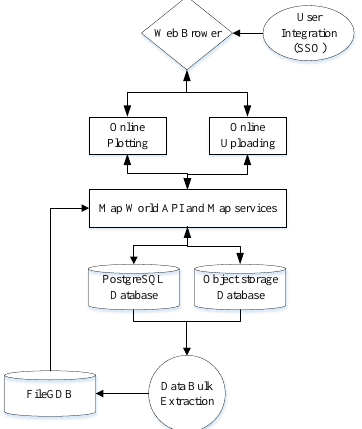
Figure 3. The technique routine of the system